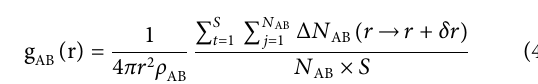
Frontiers in Chemistry |